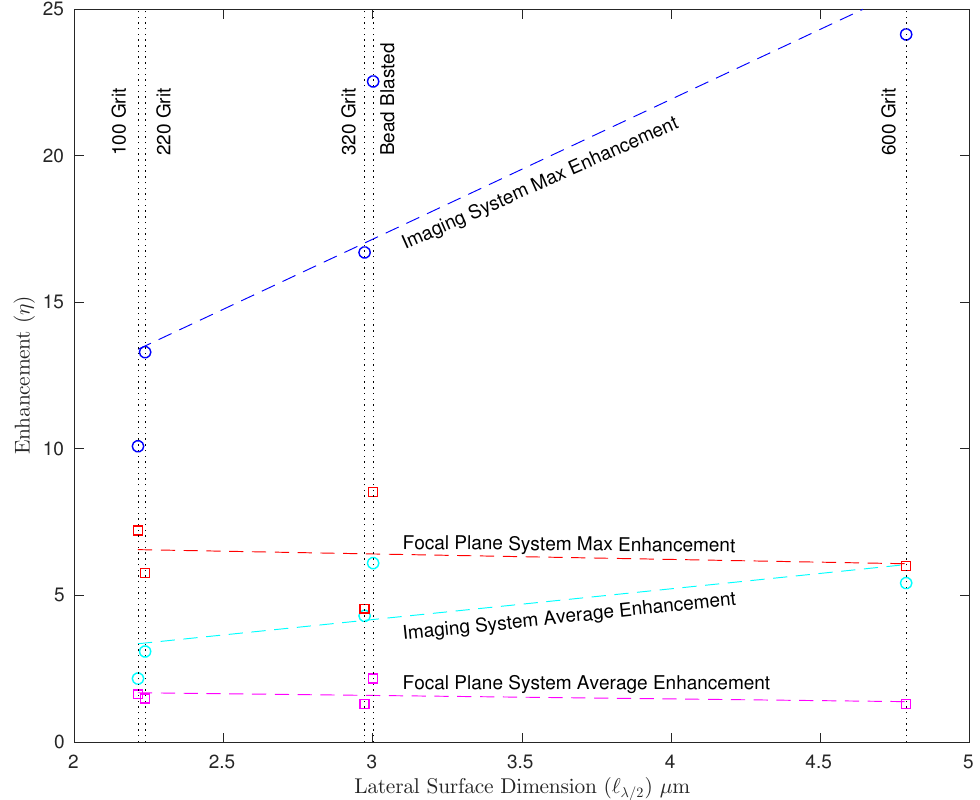
Figure 4. Enhancement ( η ) vs. Lateral surface dimension ( (cid:96) λ /2 ). The lateral surface dimension, (cid:96) λ /2 , is plotted with enhancement. The focal-plane system shows no change in enhancement with (cid:96) λ /2 . However, the average enhancement of 1 indicates that the target segment has the same intensity as the